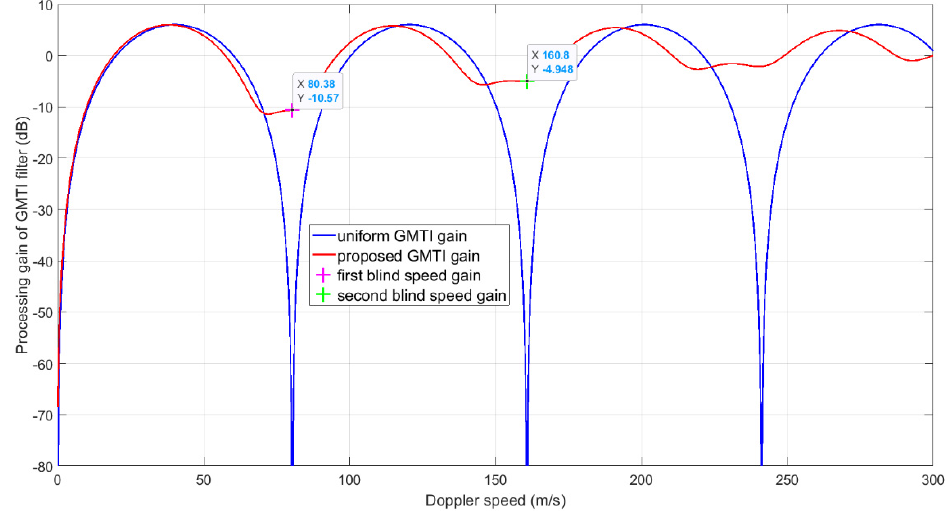
Figure 10. The MTI filter gain vs. Doppler speed for the given simulation parameters. We show the absolute value of the Doppler velocity in the graph. Essentially, the negative Doppler velocity part is symmetrical to the positive Doppler velocity part.